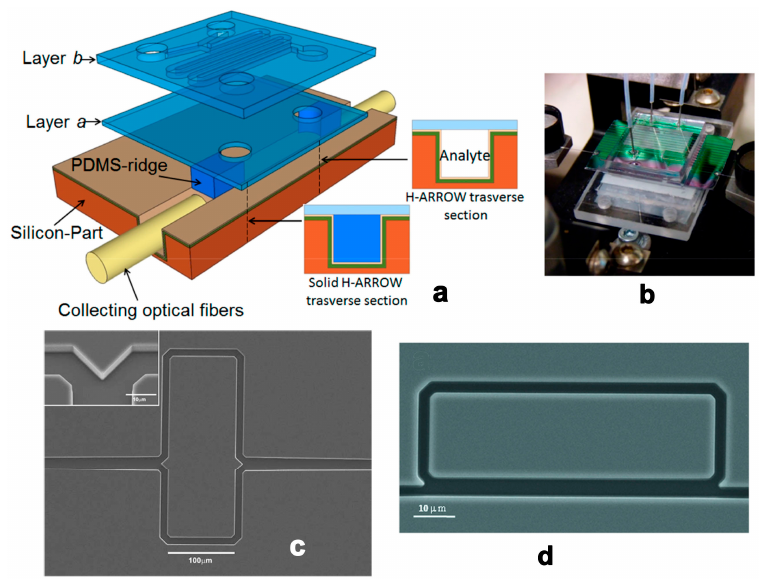
Figure 3. Schematic ( a ) and fabricated chip ( b ) of the sensor based on hybrid ARROW optofluidic platform. Reprinted with permission from [34]. Copyright (2014) OSA; ( c ) SEM picture of liquid-core ARROW. Reprinted with permission from [36]. Copyright (2010) OSA; ( d ) SEM picture of the integrated silicon optofluidic ring resonator. Reprinted with permission from [37]. Copyright (2010) AIP.